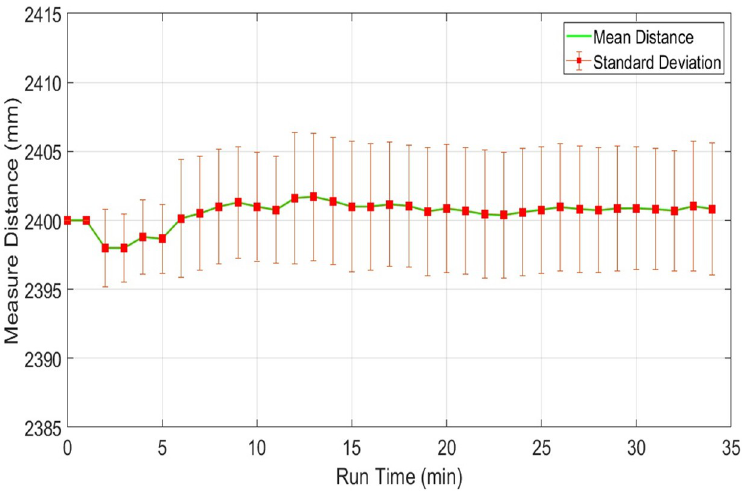
Fig 14. Range plot of Hokuyo-30LX for measuring stability test for object present at 2.4m distance.